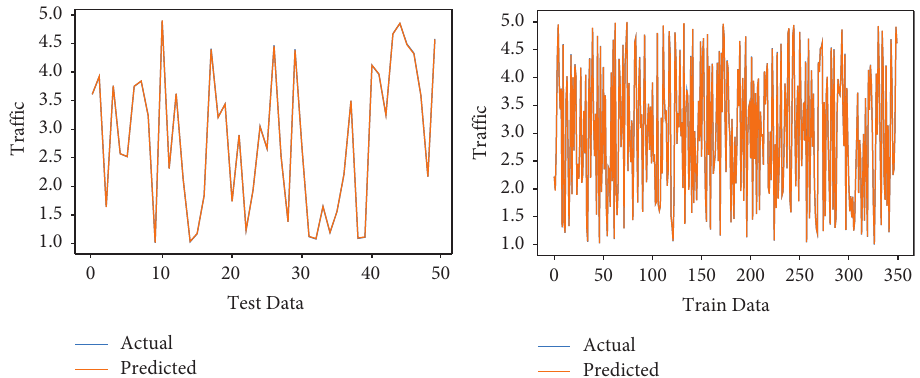
Figure 10: Processing for test data (a) and training (b) in the proposed method.